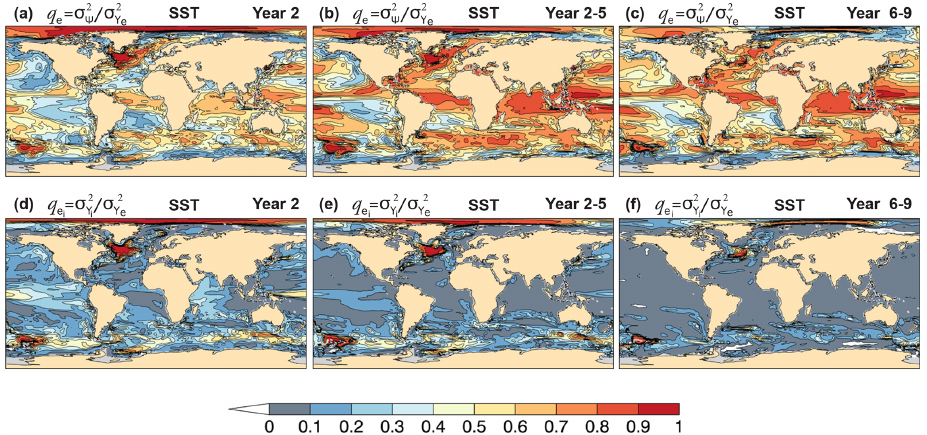
Figure 3. Potential predictability of CanESM5 annual mean sea surface temperature hindcasts. (a–c) Potentially predictable variance frac- /σ 2 tion q e = σ 2 , Eq. (4), and (d–f) the portion q e (cid:57) Y e (c, f) Year 6–9.